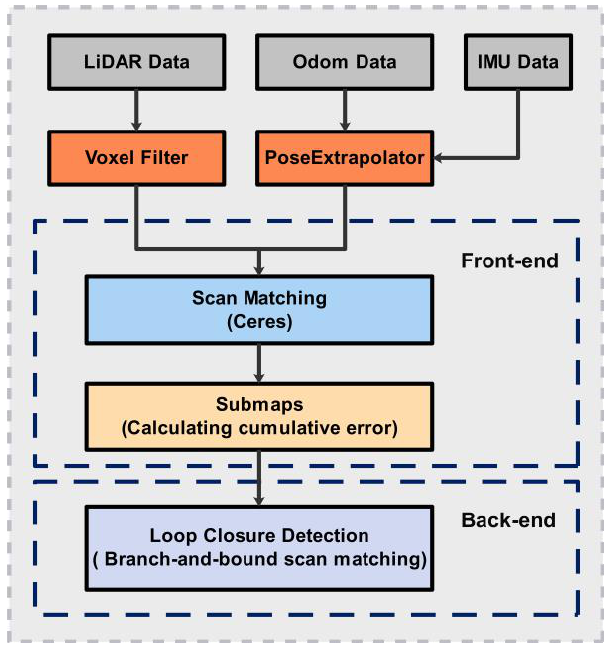
Figure 3. Flowchart of the Cartographer algorithm